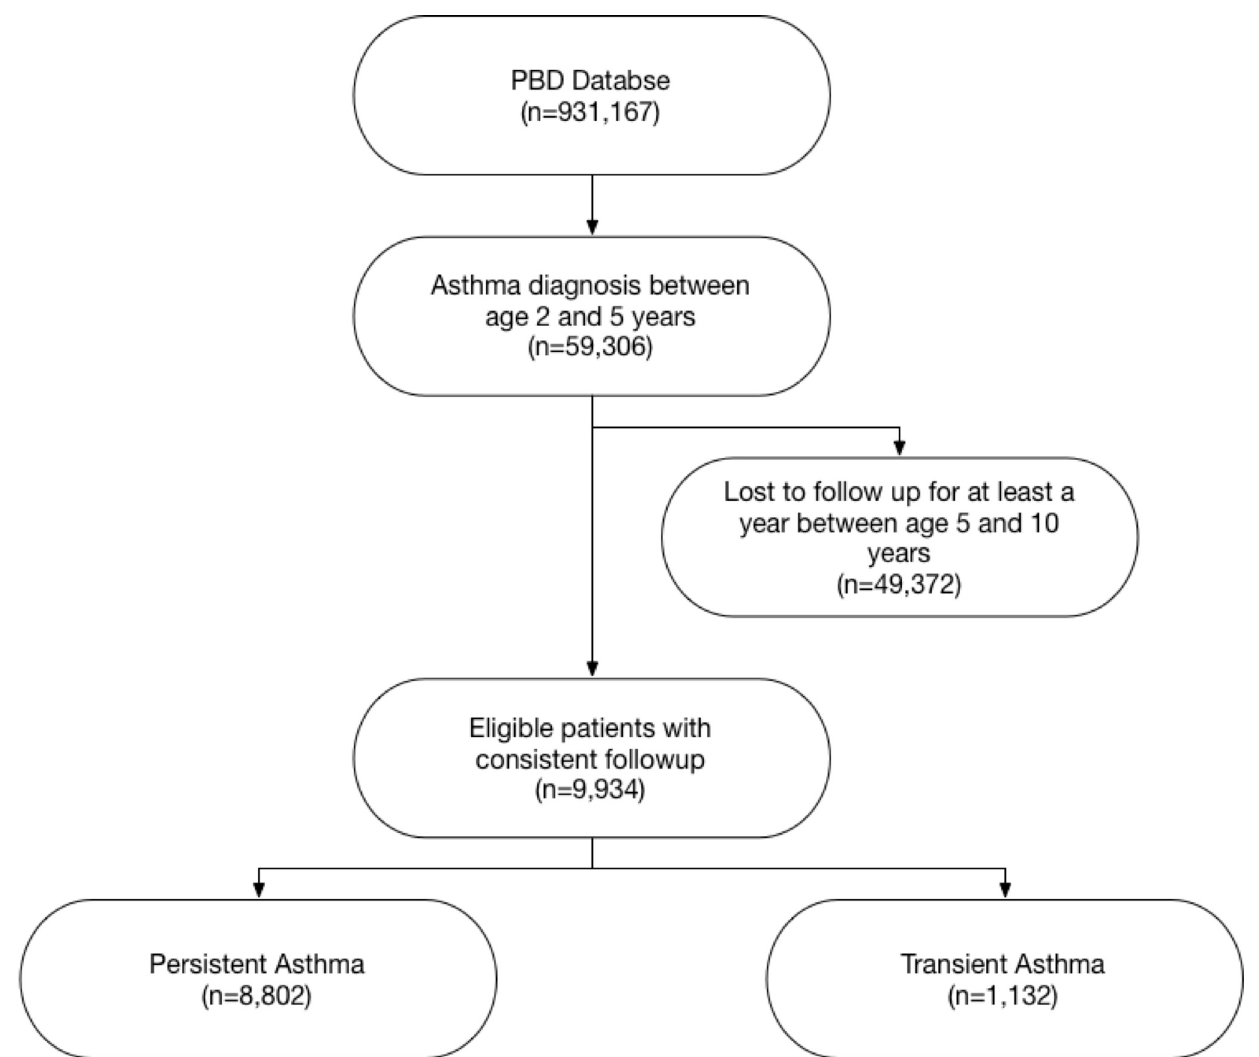
Fig 1. Study flow diagram. Excluded patients that were lost to follow up between age of 5 and 10 years.